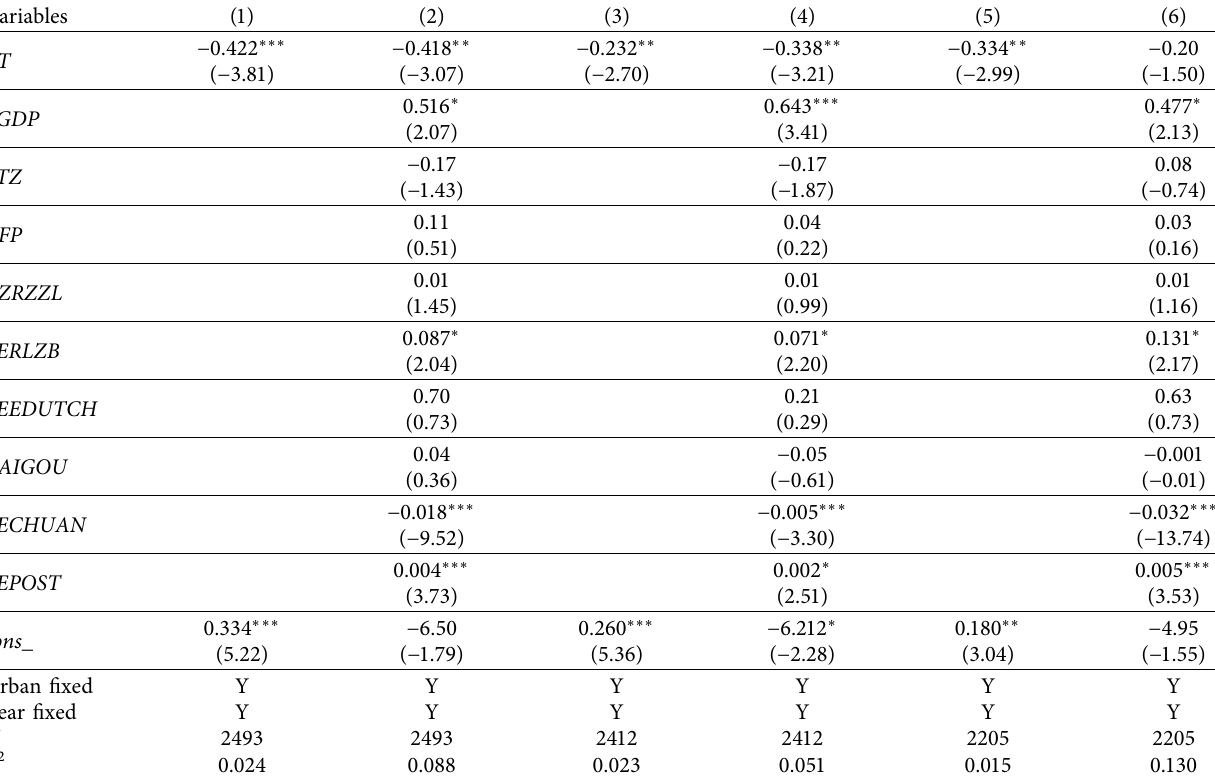
Table 4: Baseline regression results.